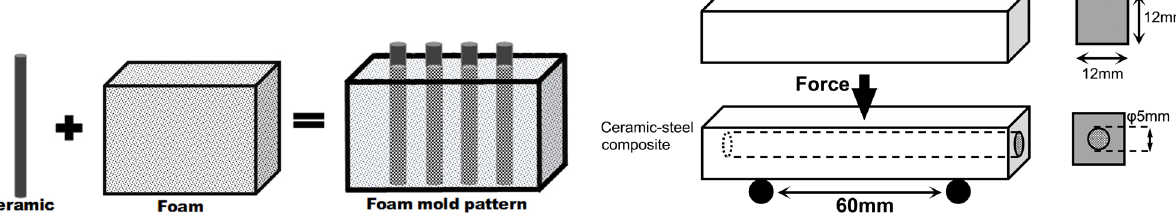
Figure 1: Schematic picture of composite foam pattern.